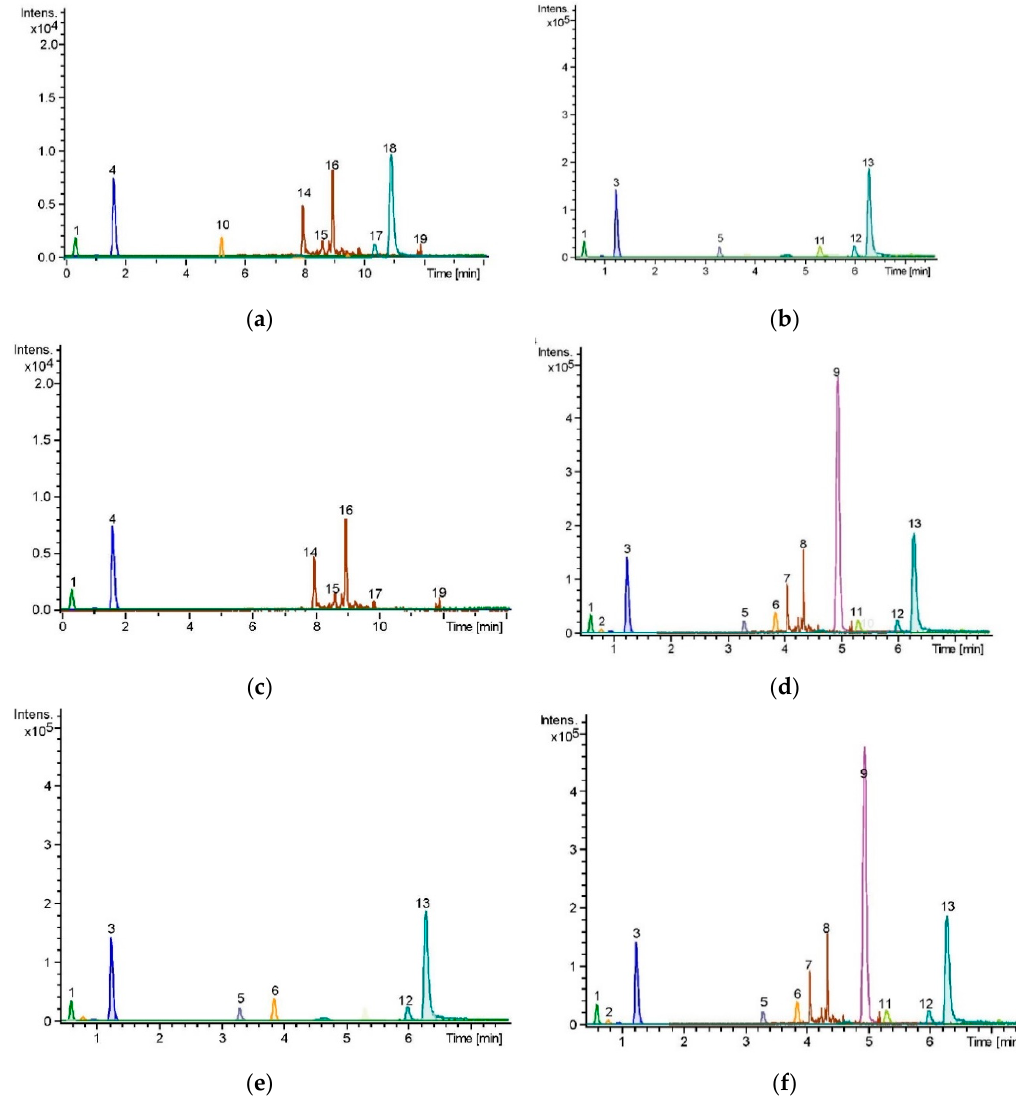
Figure 8. Extracted ion chromatograms (EICs) of the PPRFs by UHPLC-MS. ( a ) PPRF1 ( b ) PPRF2 ( c ) PPRF3 ( d ) PPRF4 ( e ) PPRF5 ( f ) PPRF6.